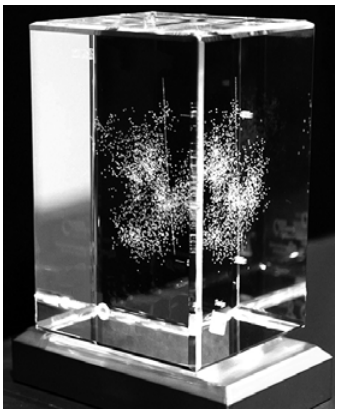
Figure 12. Sample for 3D data, relevant for cultural heritage: seismic activity preserved in crystal (courtesy by R. Titze/ comp. LOOXIS, Hannover (Germany), sample modified by Schuhr) 6